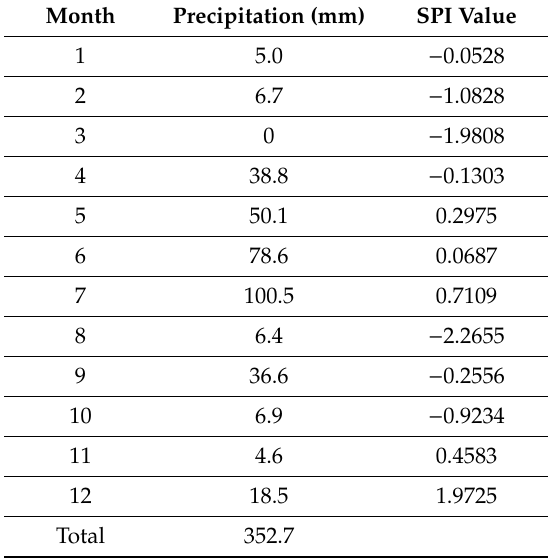
Table 6. Precipitation and SPI index values of each month in 2013 in Jinghui Channel Irrigation